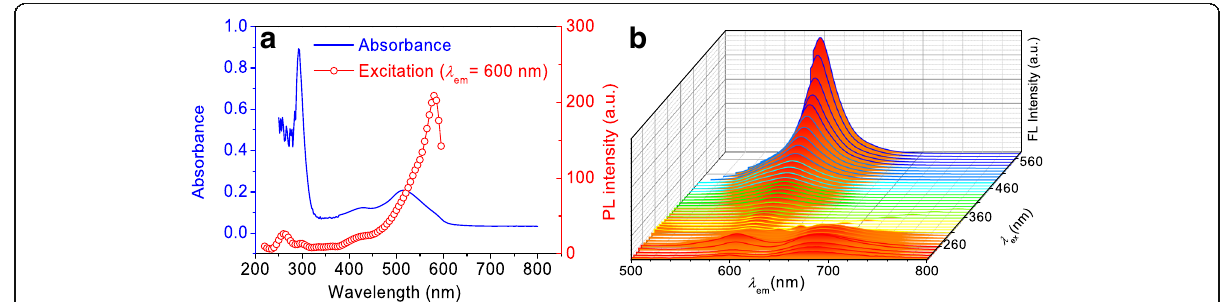
Fig. 3 a UV-Vis absorption, excitation (peak at 600 nm), and b emission (excited 220 – 580 nm) spectra of